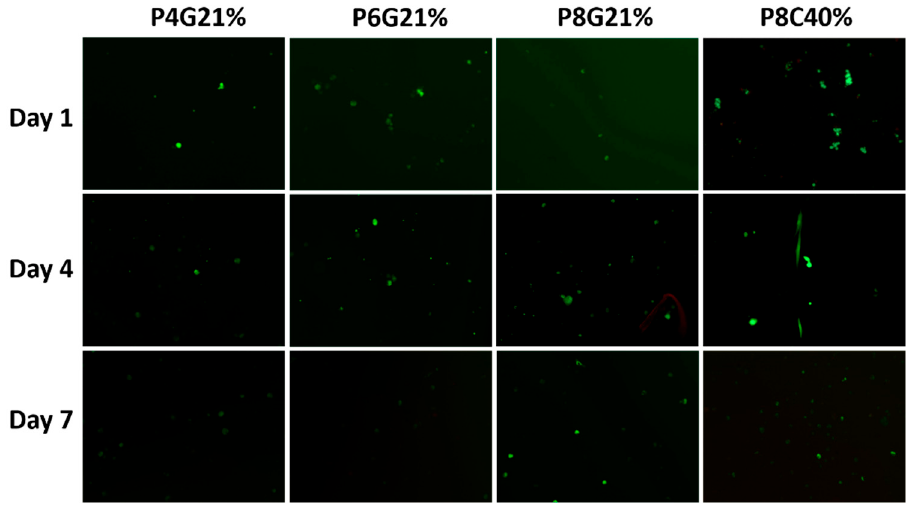
Figure 6. Fibroblast cell growth on DN hydrogels on P4G21%, P6G21%, P8G21%, and P8C40%. Live/Dead stain images of the cells.